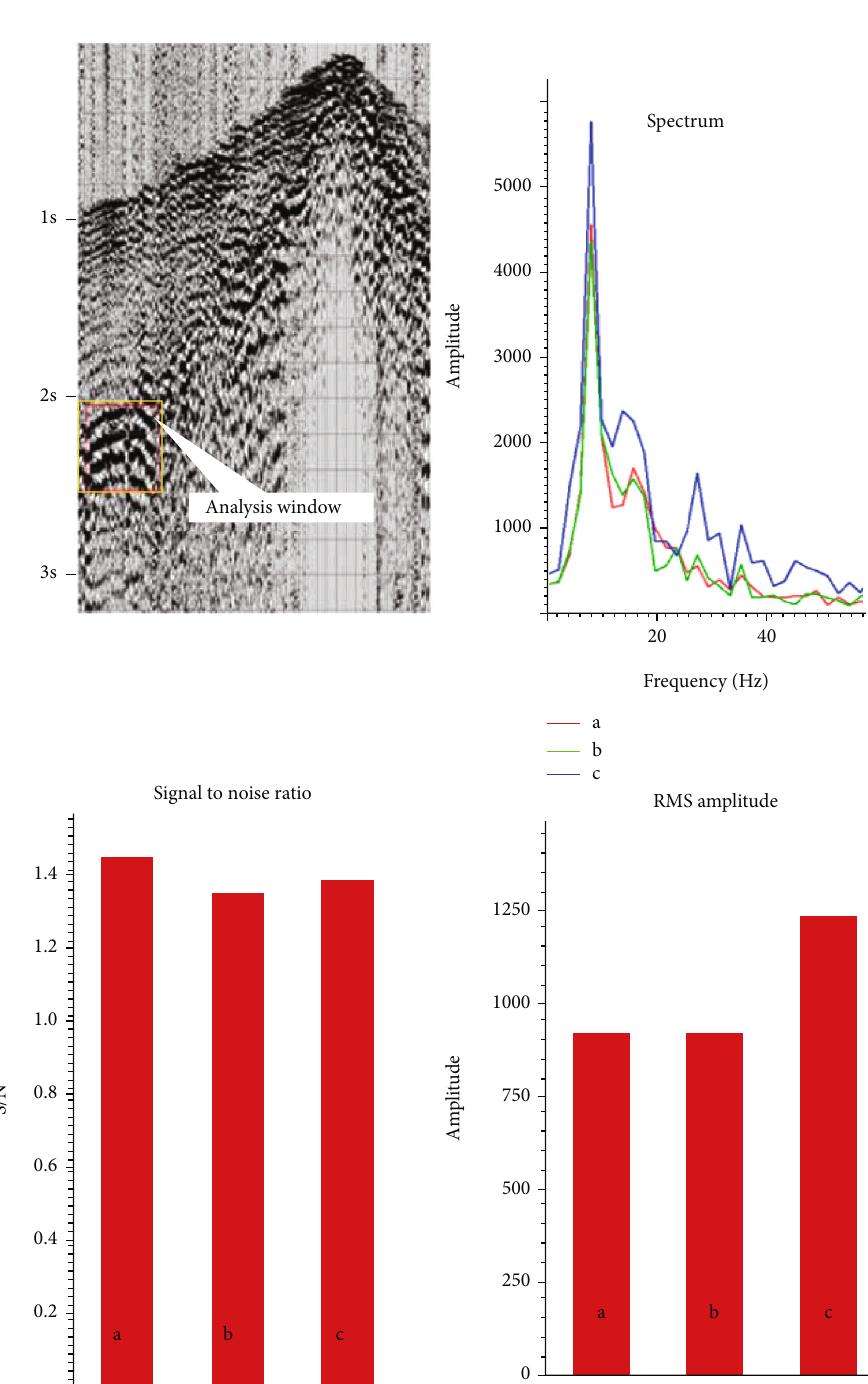
( α , R is the near- , R ) and thus the operator shape, and performing a 0 N NIP coherence analysis along the stacking operator in the multi- coverage data. The three parameters yielding the highest Figure 15. From top to bottom and from right to left edge, , R ) are N NIP sample O